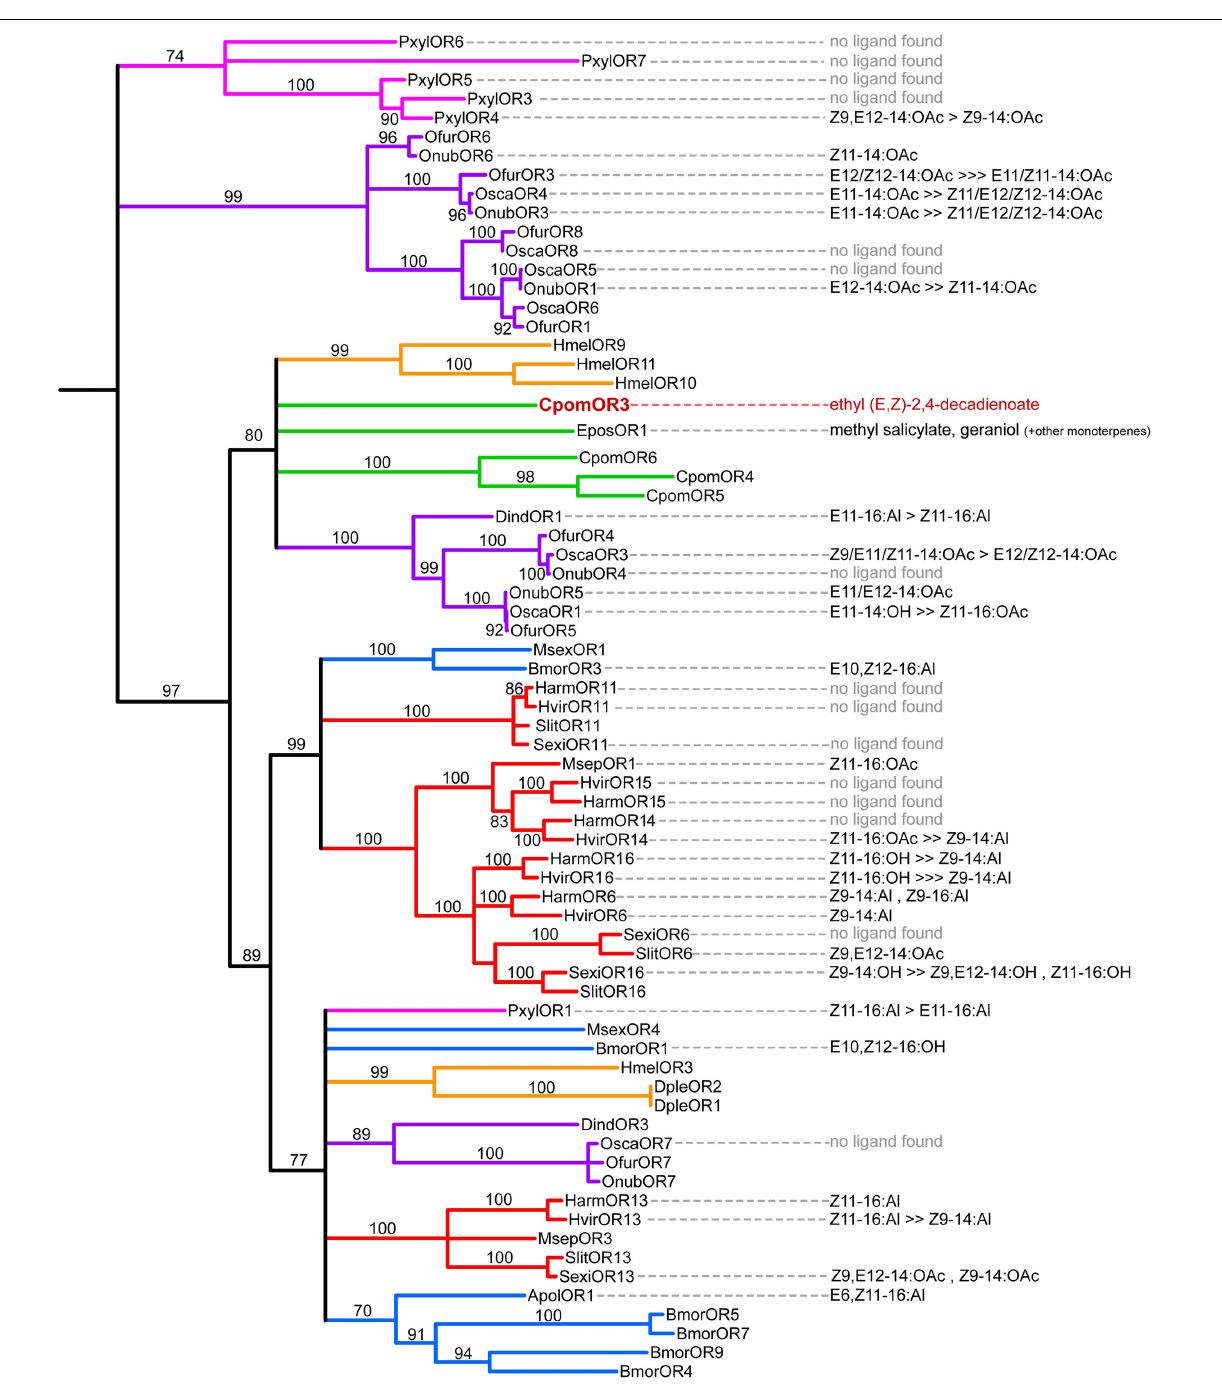
ligand found”: OR did not respond to any tested pheromone component. Cpom, Cydia pomonella , Apol, Antheraea polyphemus , Bmor, Bombyx mori , Dple, Danaus plexippus , Dind, Diaphania indica , Epos, Epiphyas postvittana , Hmel, Heliconius melpomene , Harm, Helicoverpa armigera , Hvir, Heliothis virescens , Msex, Manduca sexta , Msep, Mythimna separata , Ofur, Ostrinia furnacalis , Onub, O. nubilalis , Osca, O. scapulalis , Pxyl, Plutella xylostella , Sexi, Spodoptera exigua , Slit, S. littoralis